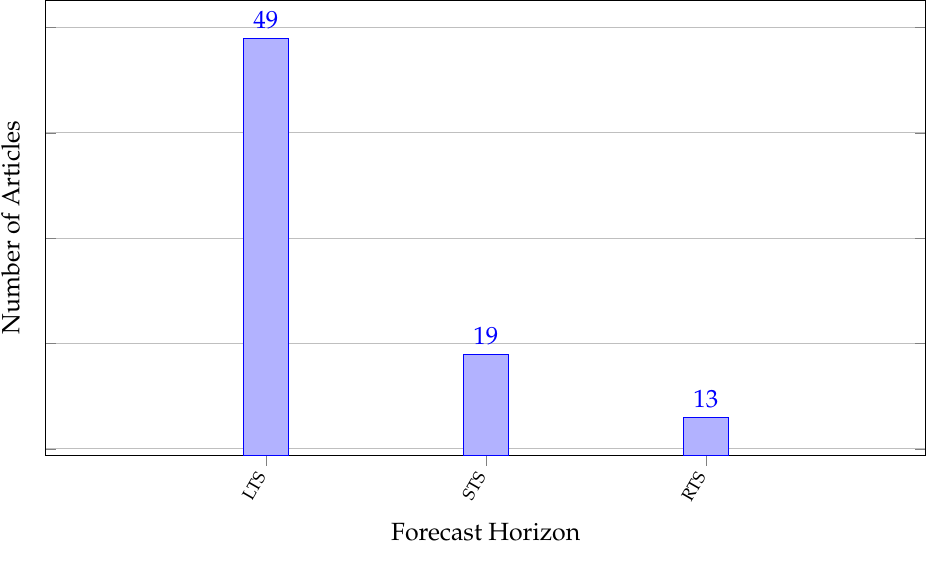
Figure 4. Works per forecast